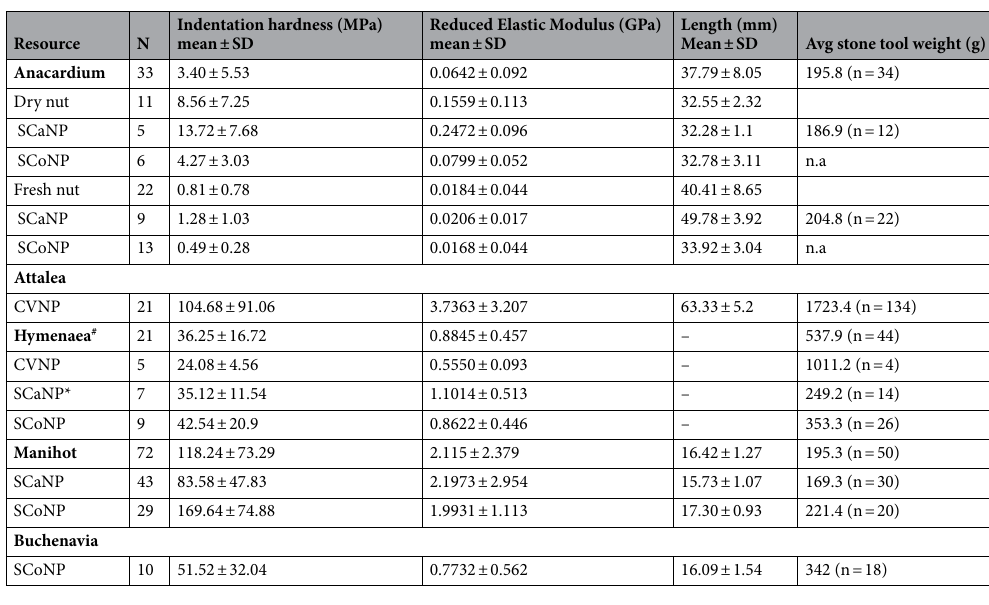
Table 4. Physical properties (indentation hardness and elastic modulus) of the food resources processed with stone tools in each area and the average stone tool weight the capuchin monkeys use to process each resource type. Some values are not available (n.a.) because the monkeys were not observed to process the resource with stone tools in that population. *Data on stone tool weight for Hymenaea in SCaNP from 31 . # The Hymenaea species at SCoNP is H. martiana , and in SCaNP is H. courbaril . The species sampled at CVNP is unknown, as there are two similar species in the area, H. courbaril and H. stignocarpa 32 . We compared them at the genus level in this work. The length value is not shown for Hymenaea because the samples were often fragmented, not allowing the measure of the original